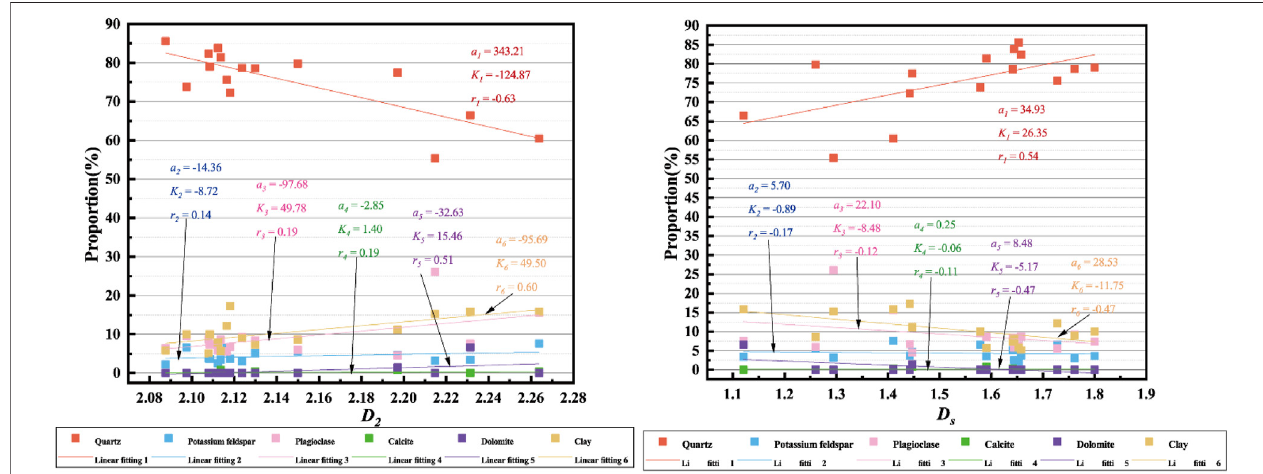
FIGURE 13 | Correlation relationship of 2D and 3D fractal dimension with mineral components.